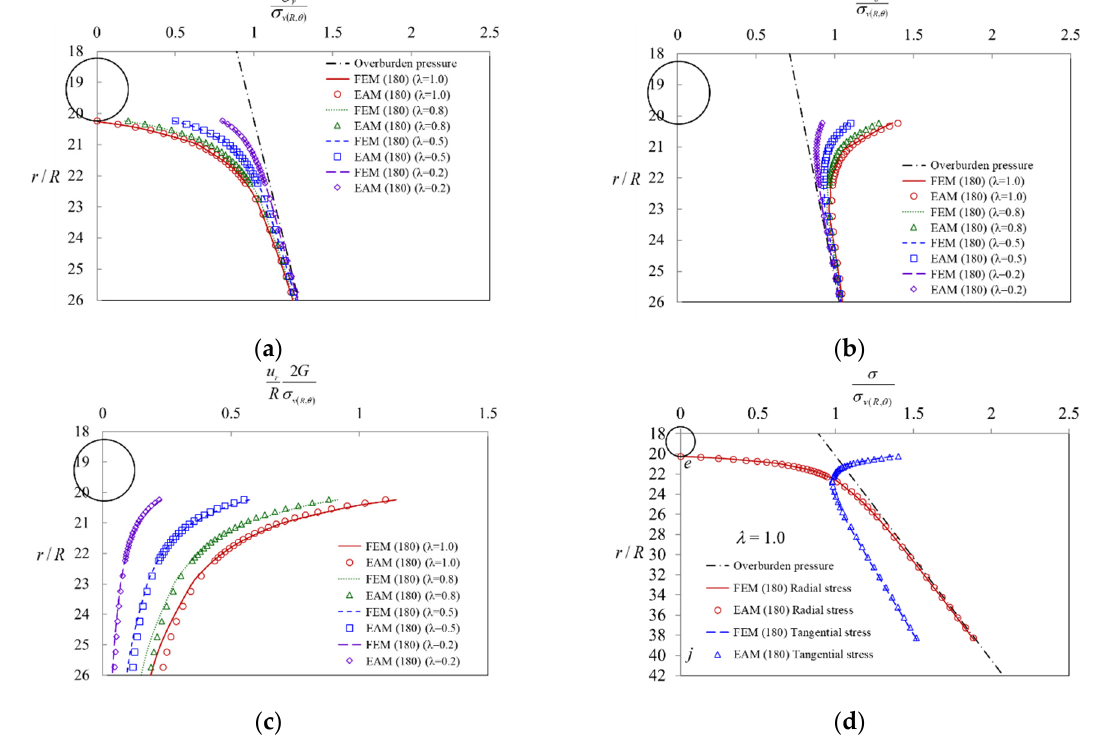
Figure 16. Ground reaction around the tunnel obtained by EAM and FEM with the different incre- mental values λ in an elastic media, and the distribution of ( a ) radial stress, ( b ) tangential stress, ( c ) radial displacement, and ( d ) tangential and radial stresses with λ = 1.0 (Case III, θ = 180°, along the deep line and K o = 0.8).